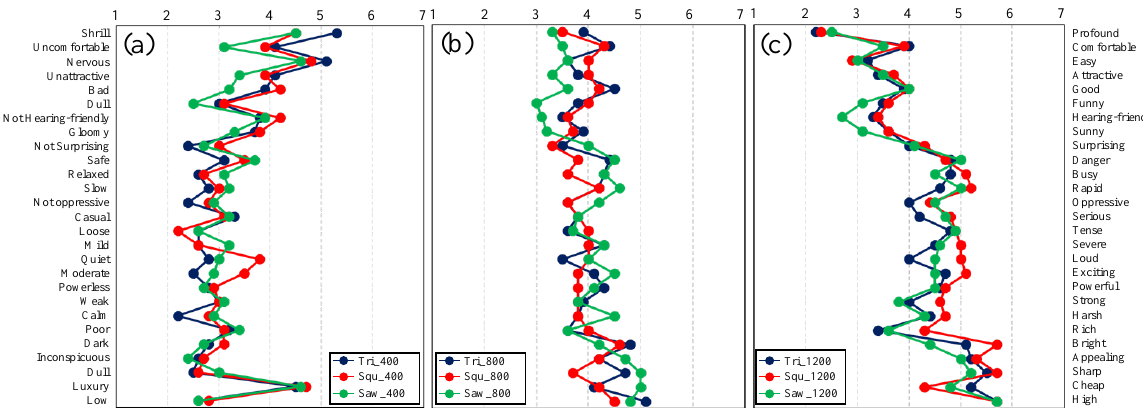
Figure 6. Average profile ratings obtained by the semantic differential (SD) test for ( a ) 400 Hz, ( b ) 800 Hz, and ( c ) 1200 Hz.